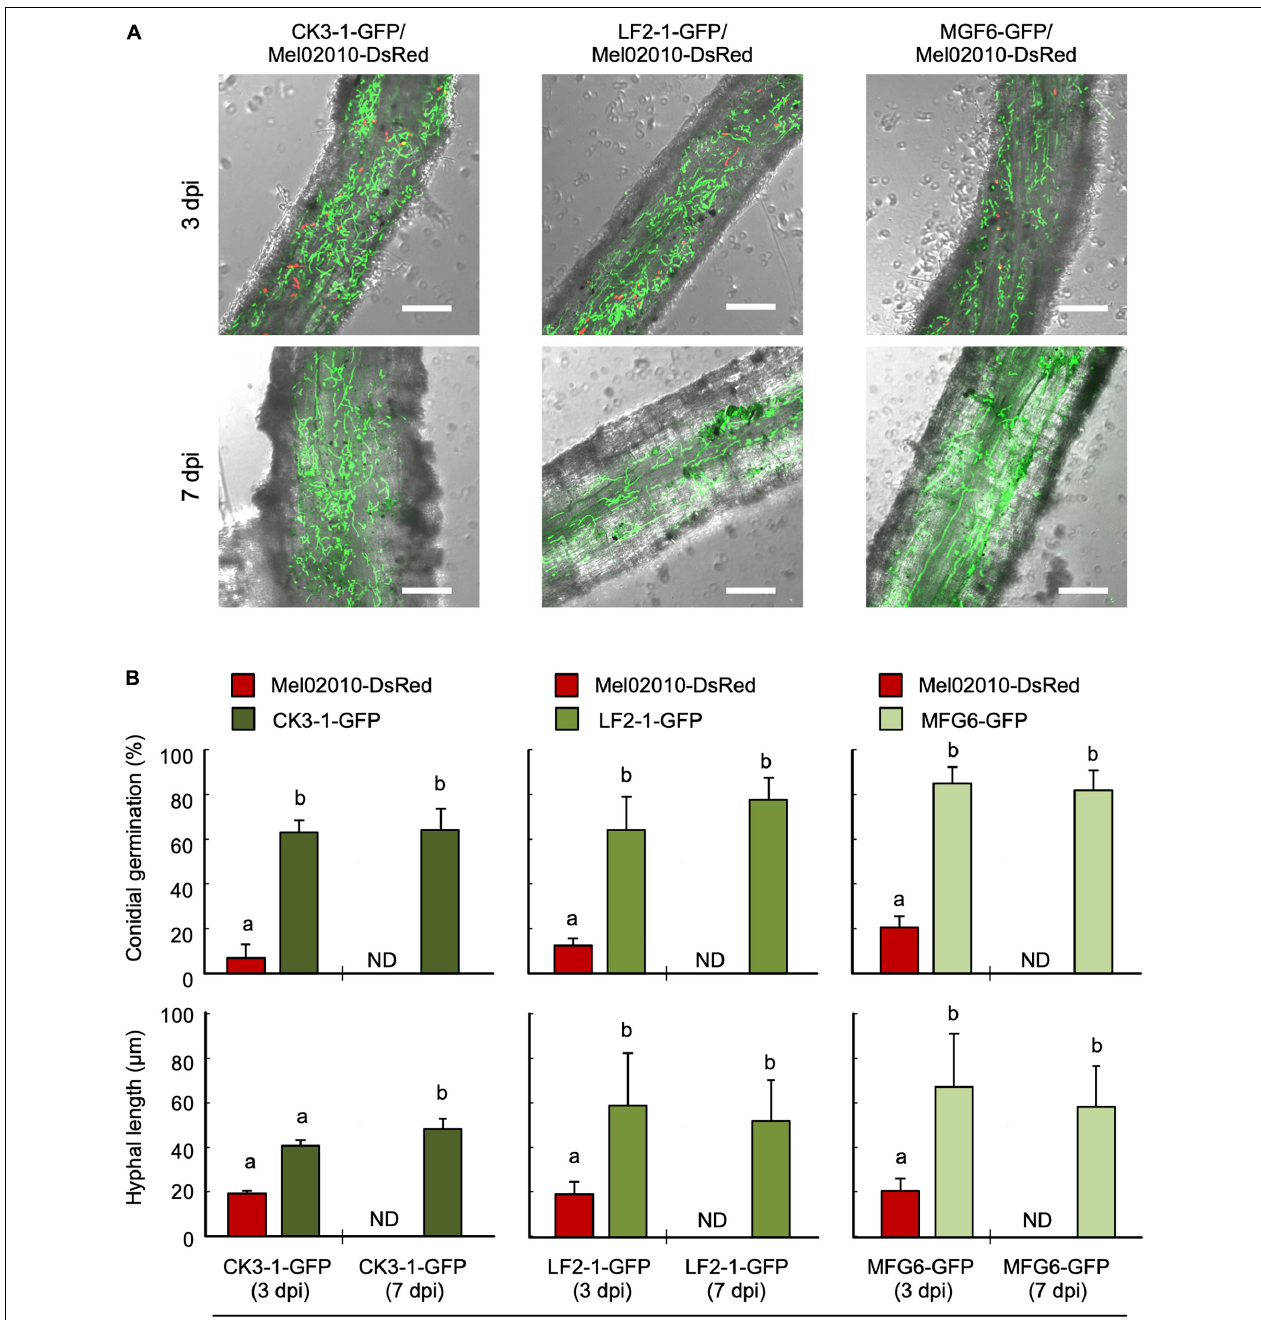
FIGURE 7 | Inhibition of conidial germination and hyphal growth of F. oxysporum f. sp. melonis on root surface by the pre-inoculation of F. oxysporum f. sp. lycopersici and its (cid:49) FOW2 strain. Roots of melon seedlings were dipped in a conidial suspension (1 × 10 8 conidia/mL) of F. oxysporum f. sp. lycopersici strains or in water, and seedlings were planted in soil infested with F. oxysporum f. sp. melonis strain (1 × 10 5 conidia/g soil). Seedlings were removed from soil at 3 and 7 dpi. (A) Root surface viewed with a laser scanning confocal microscopy (LSCM). Bar = 50 µ m. (B) Percentage of conidial germination and hyphal length of each strain on main roots was determined 3 and 7 dpi using LSCM. Data represent means and standard errors of three replications. Columns with different letters indicate that means differed significantly at P ≤ 0.01 in the Tukey–Kramer multiple range test. ND, not detected. Mel02010-DsRed, DsRed-expressing strain of F. oxysporum f. sp. melonis ; CK3-1-GFP, GFP-expressing strain of F. oxysporum f. sp. lycopersici ; LF2-1-GFP, FOW2 mutant of CK3-1-GFP; MGF6-GFP, GFP-expressing nonpathogenic F. oxysporum strain.